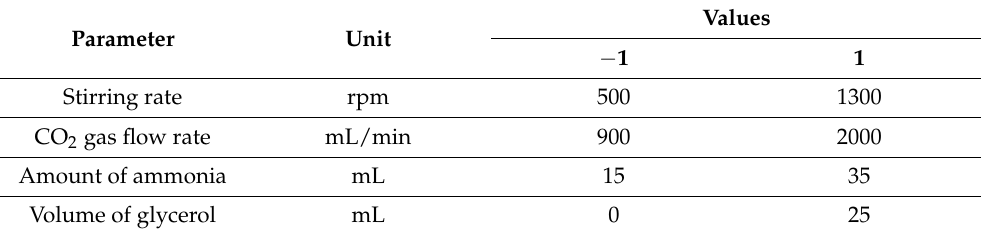
Table 4. Design of experiment matrix for CaC 3 .